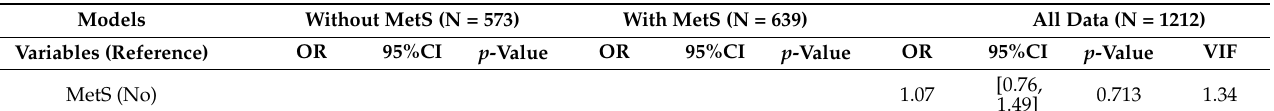
Table 4. Comparisons of risk factors of DN between type 2 DM patients with and without